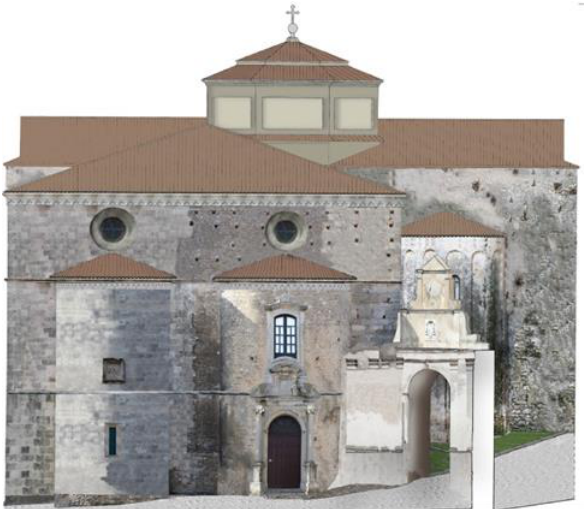
Figure 1. Digital reconstruction of the apses prospect